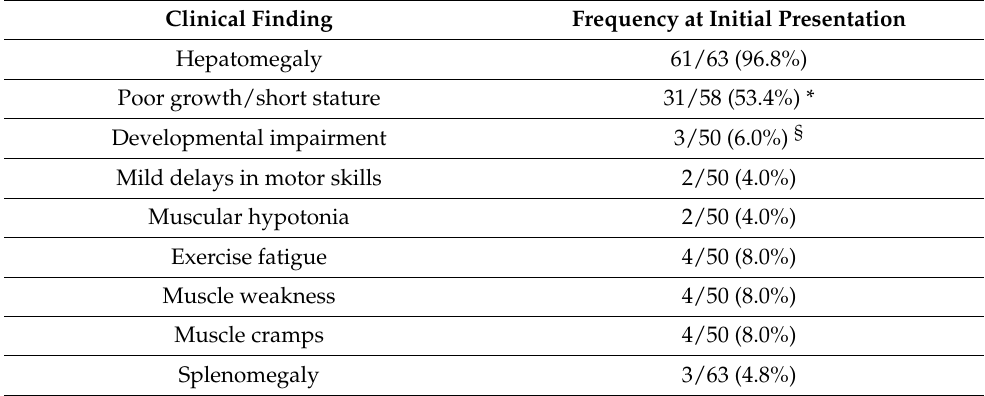
Table 1. Clinical findings and their frequencies at initial presentation in patients with GSD